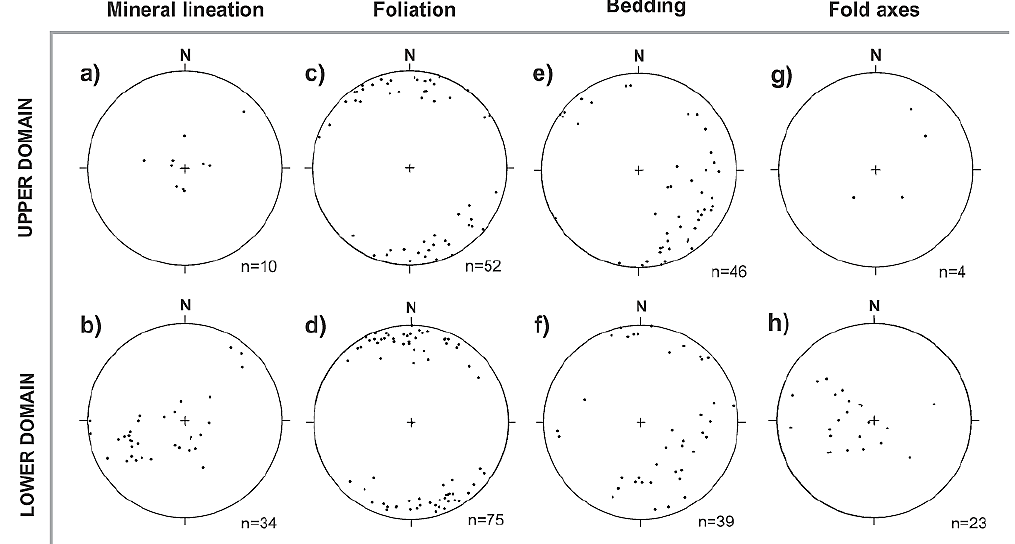
Fig. 8. Lower hemisphere, equal-area stereographic projections of main structural elements in the Kristineberg area. The structural planes in (c, d) and (e, f) are visualized as poles to the respective planes. The upper and lower crustal domains occur to the north and south of the high-strain zone “II” in Fig. 2a,